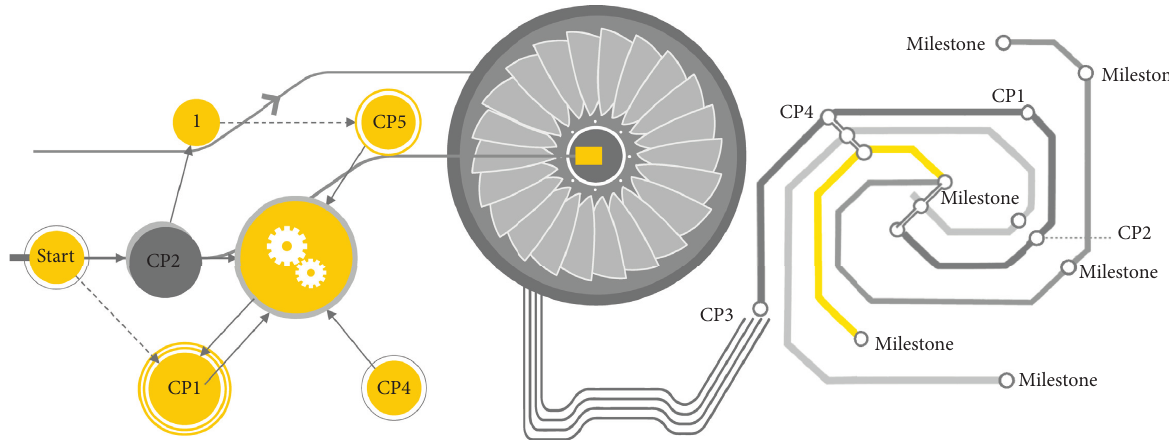
Figure 6: The model diagram of the subway DC bus. The process among CP1 ∼ CP3 and